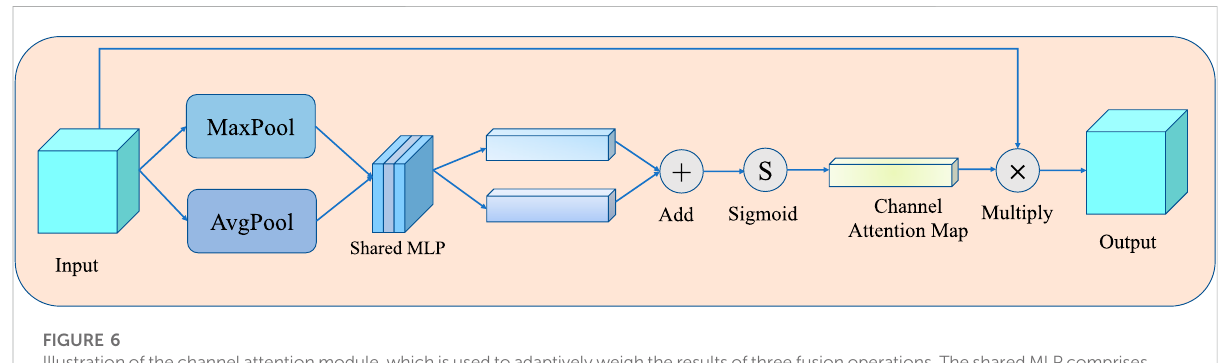
FIGURE 6 Illustrationofthechannelattentionmodule,whichisusedtoadaptivelyweightheresultsofthreefusionoperations.ThesharedMLPcomprises 1×1 Conv, Relu, and 1×1 Conv.